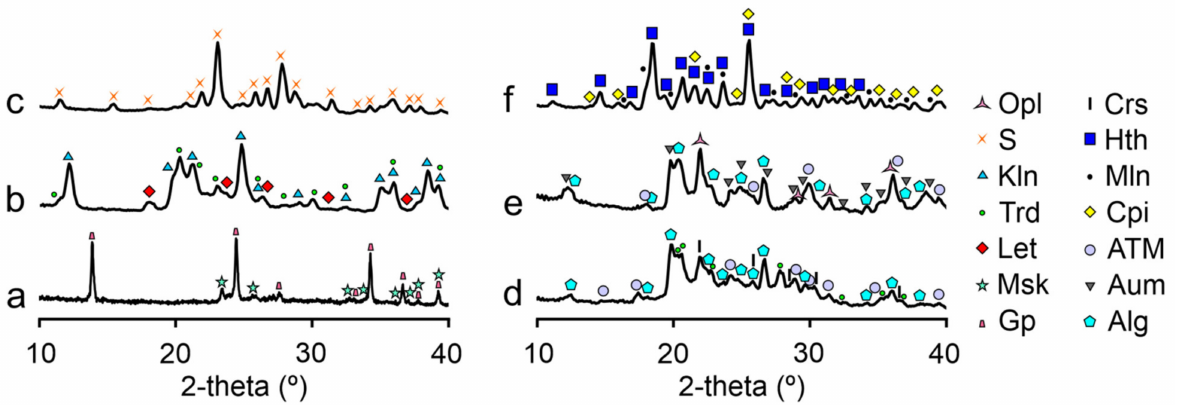
Figure 3. Powder X-ray diffraction patterns of efflorescent minerals from Donnoe fumarole field ( a – c ) and Dachnoe thermal field ( d – f ). Hth—halotrichite, Mln—melanterite, Cpi—copiapite, ATM—